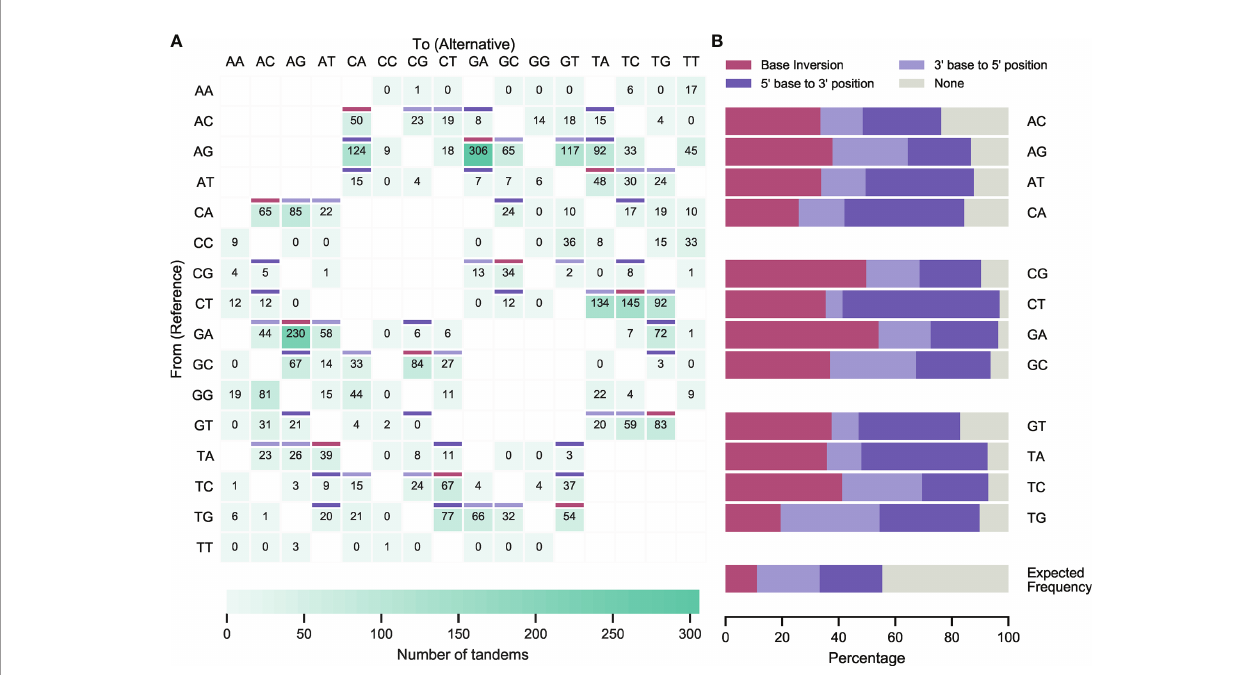
FIGURE 4 | Corrected incidence of tandem dinucleotide substitutions in healthy donors. (A) Dinucleotide substitutions from unique IGHV, IGKV and IGLV sequences from the Leiden healthy donor cohort and corrected after in silico predictions of dinucleotide substitutions that did not occur in tandem. Burgundy cells represent sequence inversions, light and dark purple cells represent juxtalocations of the 5 ’ and 3 ’ base in the pair (as seen from the non-transcribed strand), respectively. For unshaded cells, juxtalocation could not be assessed due to one or more nucleotides in the reference sequence matching the mutated sequence. (B) Relative contribution of sequence inversions and juxtalocations.